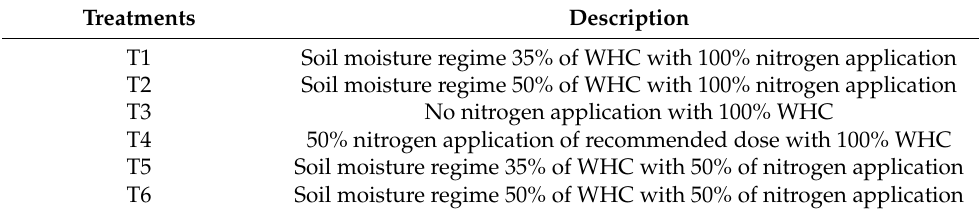
Table 1. Treatment